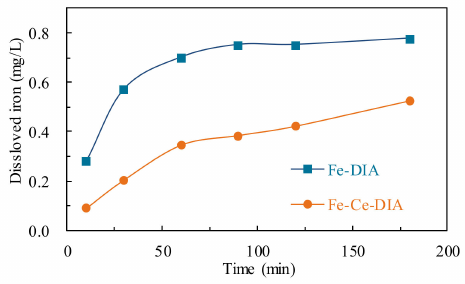
Figure 7. Determination of dissolved Fe in the tetracycline solution.